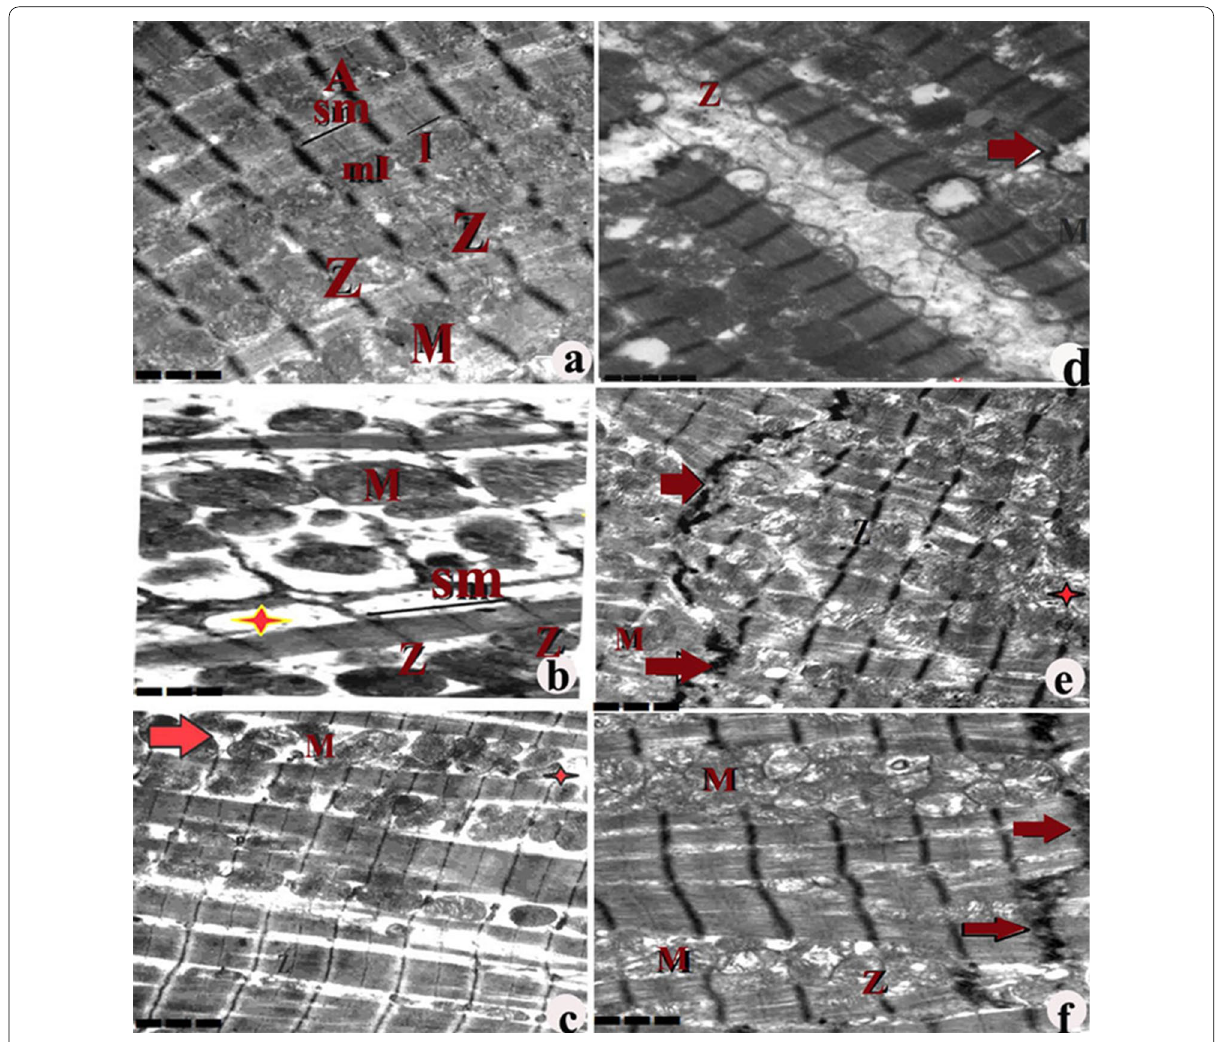
Fig. 8 Electron micrograph of a section of cardiac muscle from a control group showing parallel arrays of myofilaments comprised of regular sarcomere (Sm) with evident Z line (Z) and the M line (ml) bisect the H zone, A (dark band), I (light band). Notice the mitochondria (M) with regular cristae arranged between the myofibrils. b DMBA group demonstrating poorly organized myofibrils with disrupted Z line, areas of myofilaments degeneration (asterisk), interruption and fragmentation of myofibrils. The sarcoplasmic reticulum enveloping the sarcomere (Sm) units shows large distensions. Notice the disorganization of the mitochondria (M) and abnormal aggregation of some swollen mitochondria with disrupted cristae. c (DMBA Art) group showing cardiac muscle with poorly organized myofibrils, disrupted Z line, areas of myofilaments degeneration (star). + Notice the disorganized mitochondria (M), where some of them are swollen (arrow). d (DMBA Ech) group demonstrating cardiac muscle with + nearly fine organized myofibrils, clear Z line (Z), degeneration in some cardiomyocytes (arrow) and degenerated mitochondria (M). e (Art DMBA) + group demonstrating cardiac muscle with nearly fine organized myofibrils, clear Z line (Z), disorganized intercalated disk (arrow), little areas of degenerated myofilaments (star). Notice the mitochondria (M) with regular cristae. f (Ech DMBA) group demonstrating cardiac muscle with + well‑organized myofibrils and clear Z line (Z). Notice the mitochondria (M) with good cristae and normal distribution of intercalated disk (white arrows) (Scale bar 2 =